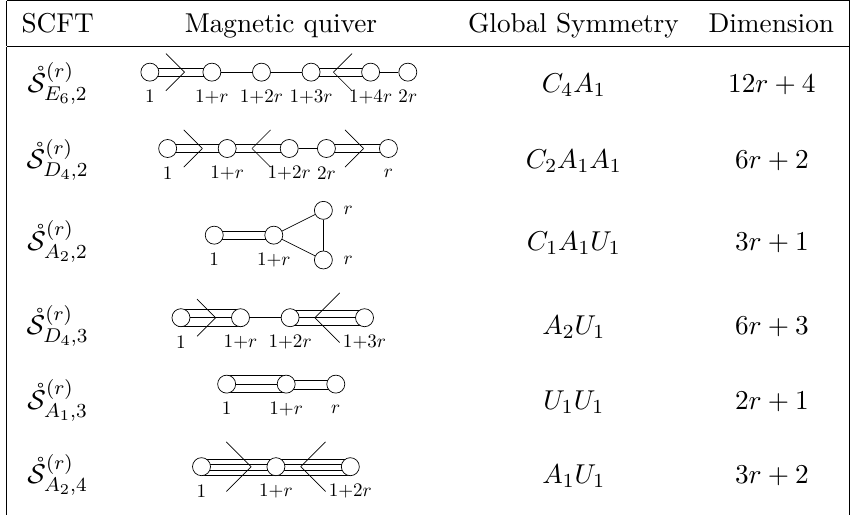
˚ theories with their magnetic quivers. The global symmetry is independent of r . Table 7. The S ( r ) G,‘ The dimension of the Higgs branch of ˚ S ( r ) is equal to the dimension of the Higgs branch of S ( r ) G,‘ Recall that a U(1) is ungauged on a long node of all the